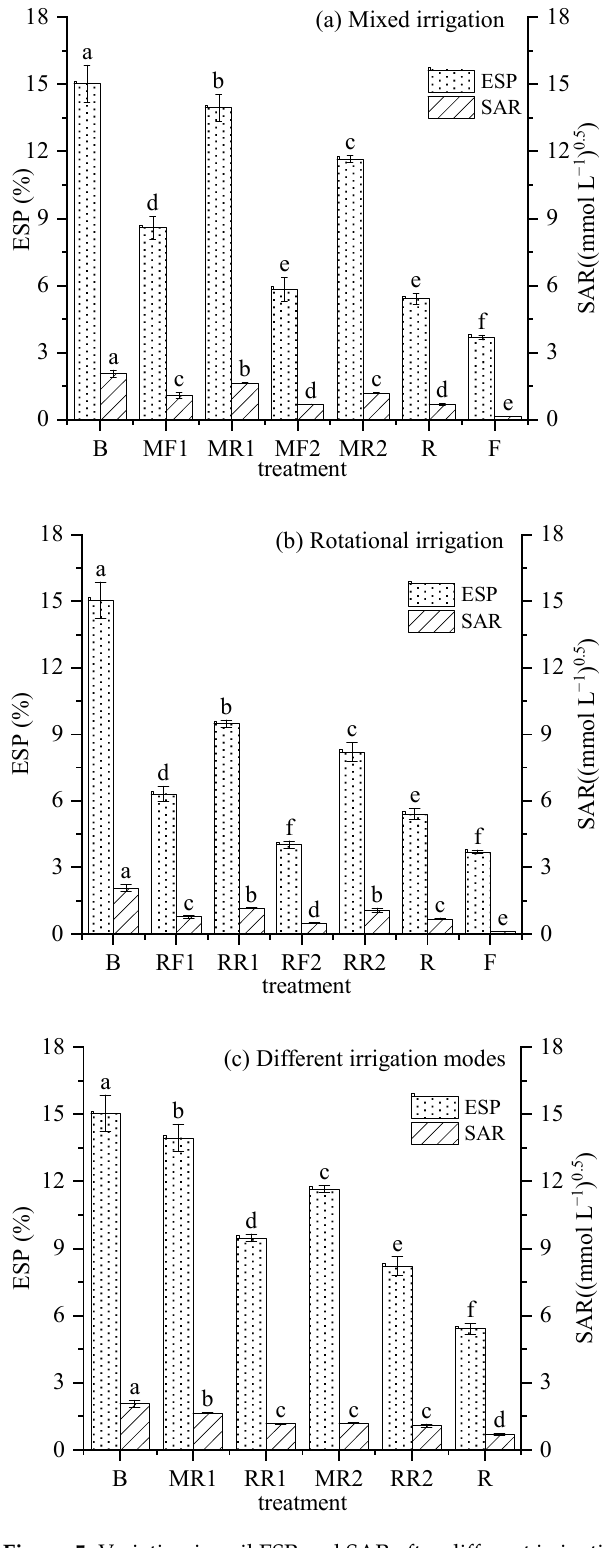
Figure 5. Variation in soil ESP and SAR after different irrigation scenarios. Note: different lowercase letters on the points represent the significant differences at the level of 0.05.